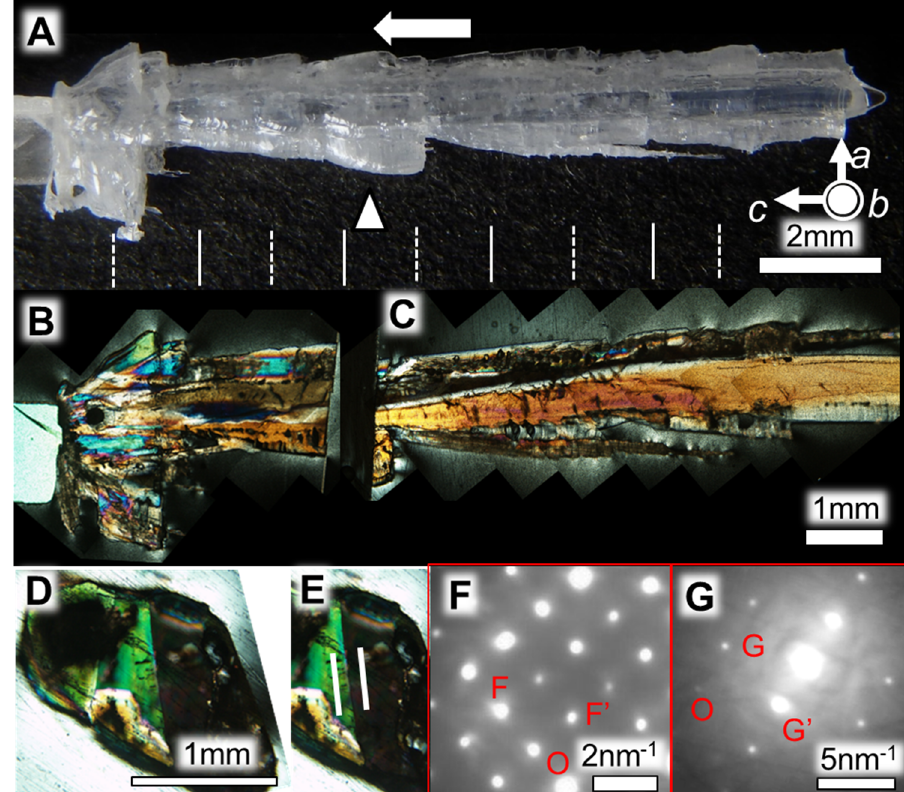
Figure 4. SBO crystal fibers grown at 1000 V/cm: ( A ) external form of SBO crystal fibers; ( B , C ) po- larized optical microscope image of the SBO crystal taken under crossed Nicols; ( D ) cross-sectional view of the crystal fiber at the white-arrowhead position of ( A ) (a portion between ( B , C )); ( E ) parts processed by FIB for the TEM/SAED observation (white lines); ( F ) electron diffraction pattern at the left of ( E ); ( G ) electron diffraction pattern at the right of ( E ). Symbols in ( A ) correspond to the crystallographic orientation of seed crystals. A white arrow corresponds to the pulling-down direction. Alternating timing of electric fields was drawn by solid lines (electrodes in the melt: +; growth fronts: − ) and dashed lines (electrodes in the melt: − ; growth fronts: +).